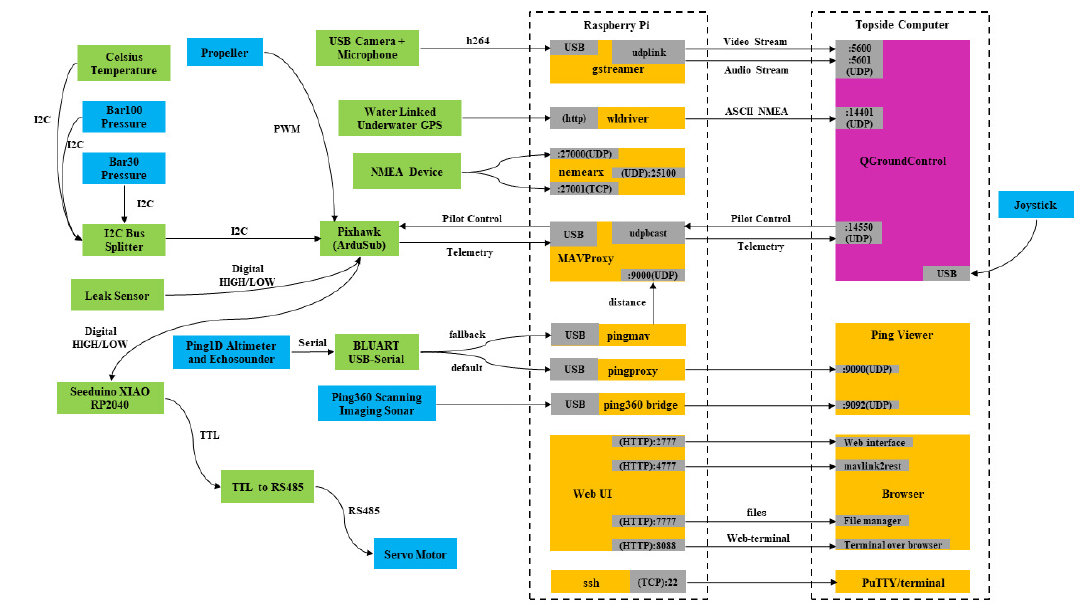
Figure 6. Software protocol